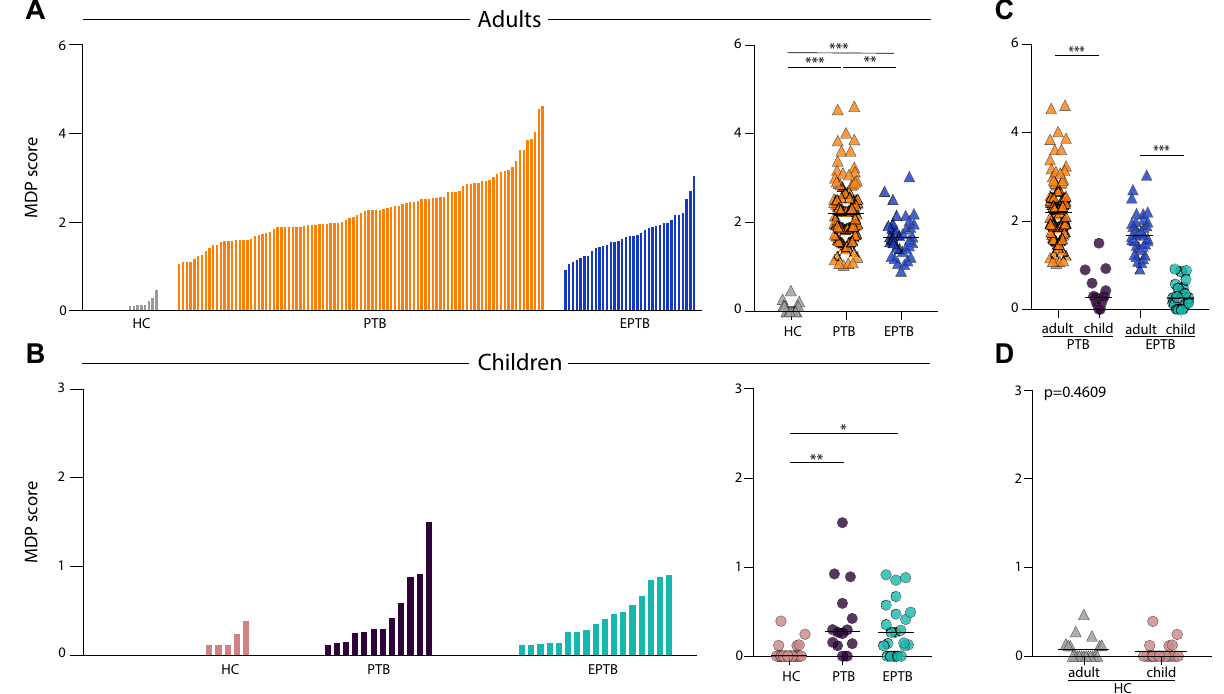
Figure 1. Adult and children with active tuberculosis exhibit substantial molecular degree of perturbation. ( A , B ) Left panels: Histograms show the single sample molecular degree of perturbation (MDP) score values relative to the healthy control group between adult and child ( PTB pulmonary TB, EPTB extrapulmonary TB, HC healthy controls). MDP values were calculated as described in Methods. The Kruskal–Wallis test with Dunn’s multiple comparisons was used to compare MDP values between each clinical group. Right panels: Scatter plots of the summary data for each group are shown. MDP score values were compared between PTB or EPTB patients ( C ) or healthy controls ( D ) from Adult and Child. Lines in the scatter plots represent median values. Data were compared using the Mann–Whitney U test. *P < 0.05; **P < 0.01; ***P <